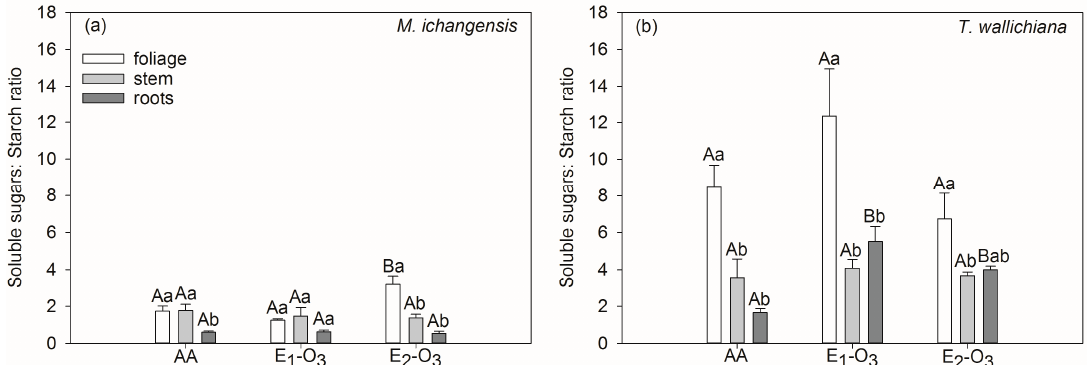
Figure 4. Ratios of soluble sugars to starch in individual tissues of M. ichangensis ( a ) and T. wallichiana ( b ) under different O 3 fumigation treatments. Different capital letters indicate a significant difference between O 3 fumigation treatments for the same tree tissues ( p < 0.05), and different lower-case letters indicate a significant difference between different tissues within the same species under the same O 3 fumigation treatments ( p < 0.05). Bars indicate standard error of the mean ( n = 3).